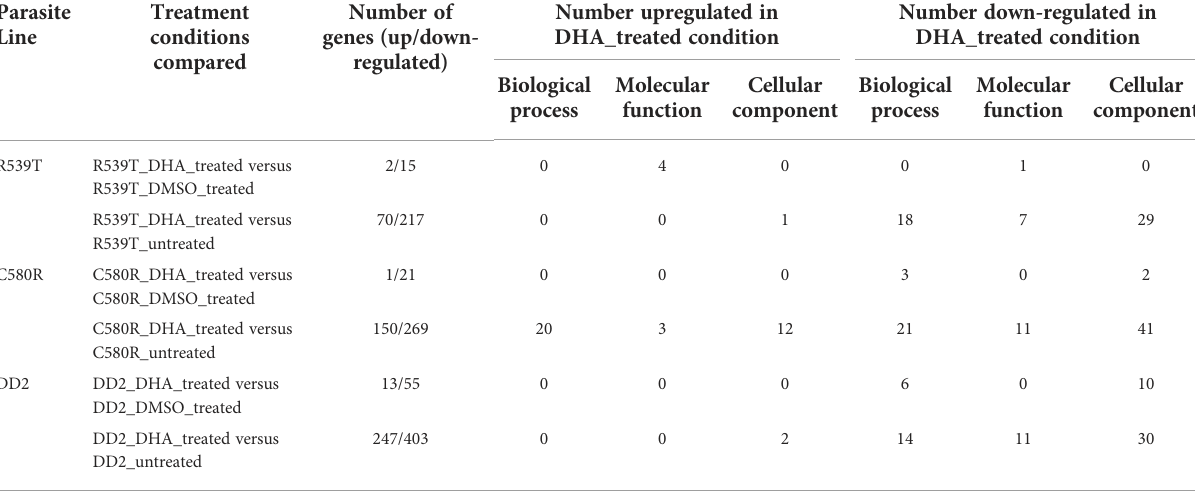
TABLE 3 Summary of gene ontology enrichment analysis, of differentially expressed genes, identi fi ed a number of signi fi cantly enriched (bonferroni adjusted p-value < 0.05) biological processes, molecular function, and cellular components among the up/down-regulated genes of the compared treatment conditions.